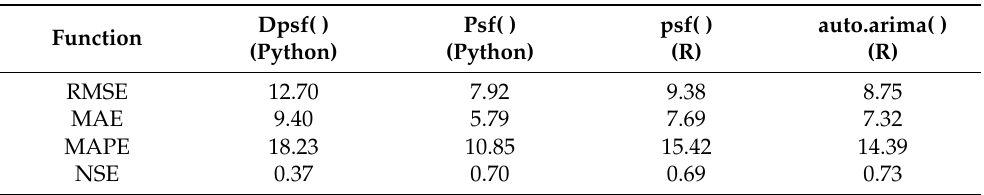
Figure 14. Result of dpsf_plot() for the “Average Bare Soil Temperature” dataset. Table 10. Comparison of forecast methods with different error metrics for the “Average Bare Soil Temperature” dataset.